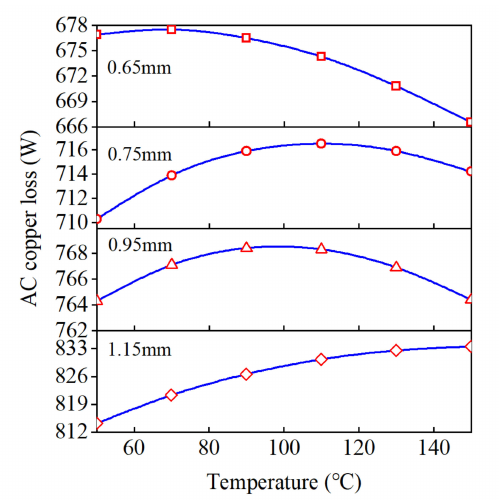
Figure 27. AC copper loss with conductor diameter at different